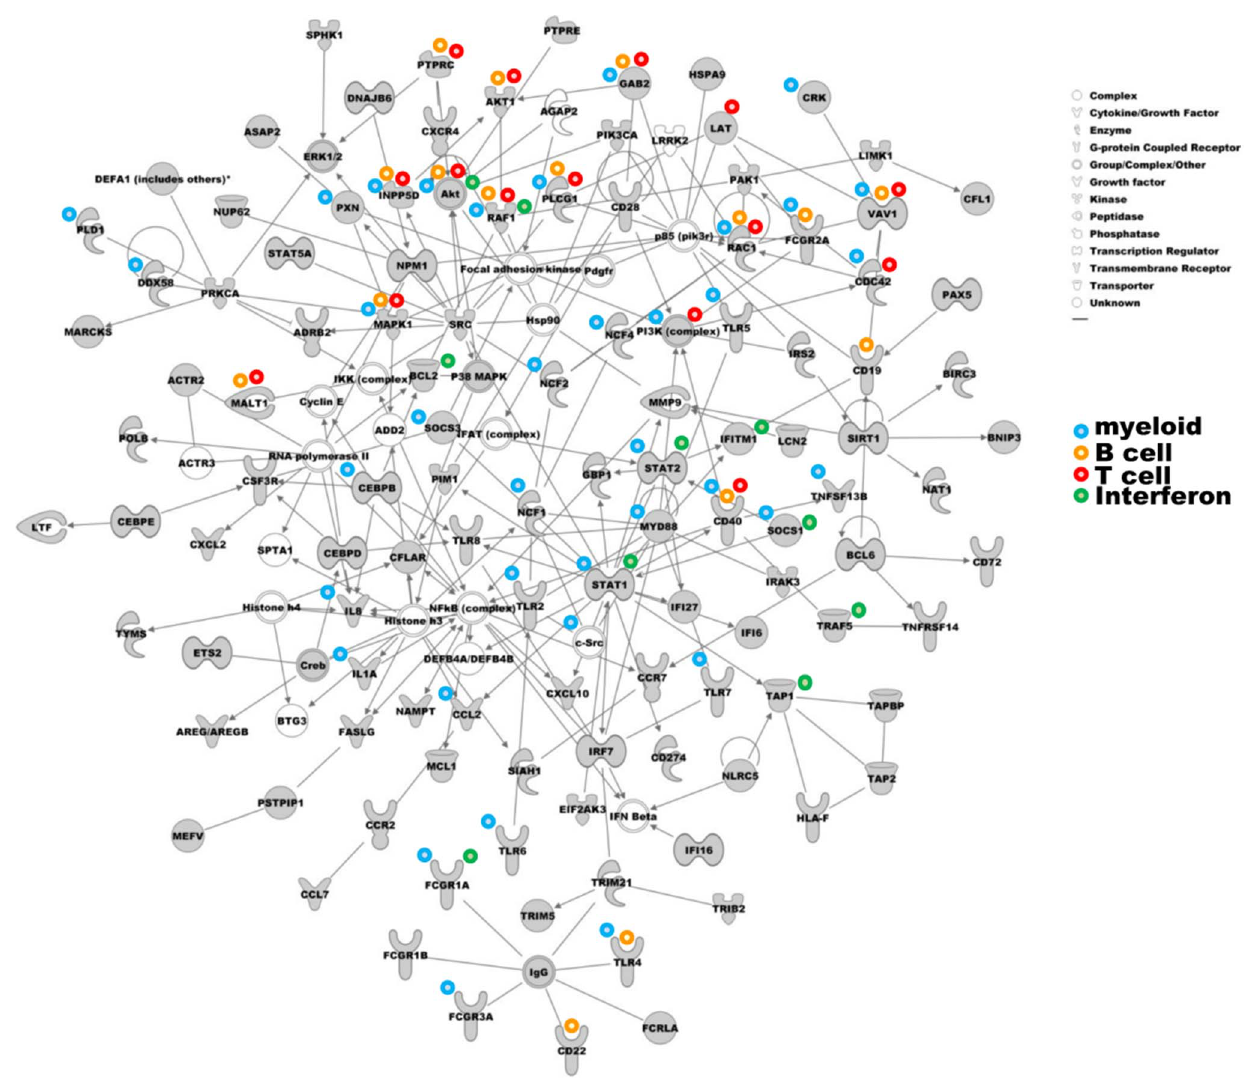
Figure 1. Ingenuity pathway analysis of all genes identified by unbiased methods related to TB disease. All 409 biomarkers were analysed by integrated pathway analysis using Ingenuity and the most dominant network is depicted here. Signalling pathways were coloured according to functional classification into myeloid cells, T cells and B cells and type I interferon related genes.